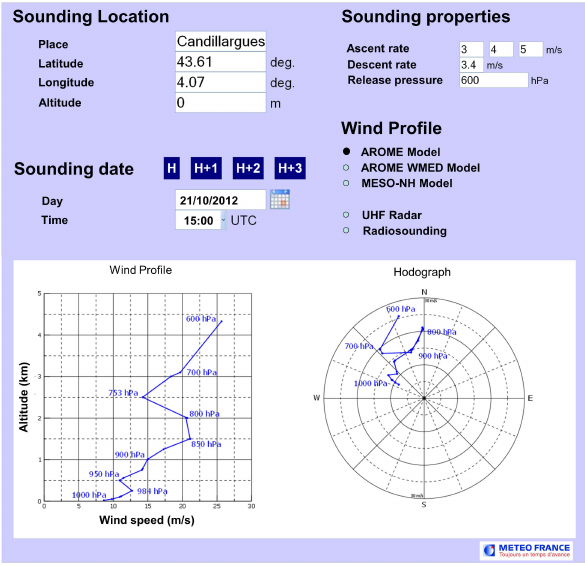
Fig. 3. Interface of the flight simulation software. Displayed wind data are used to simulate the flight trajectories shown in Fig.